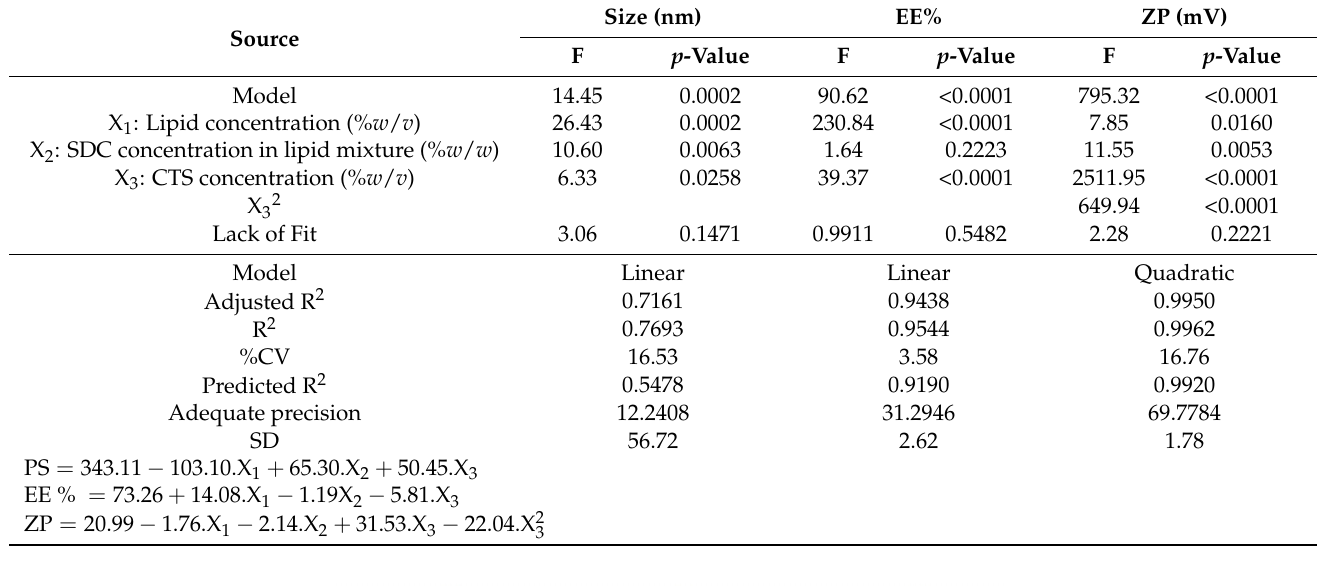
Table 3. Analysis of variance of the measured responses data.